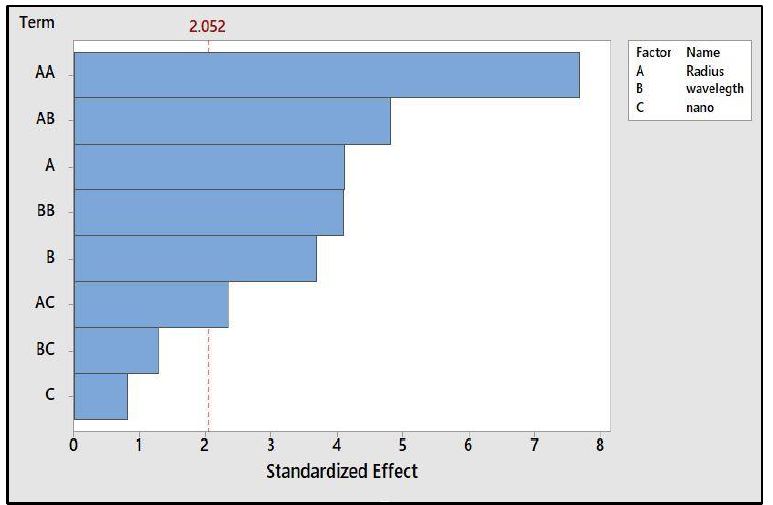
Figure 2. Pareto chart of the standardized effects of Si.